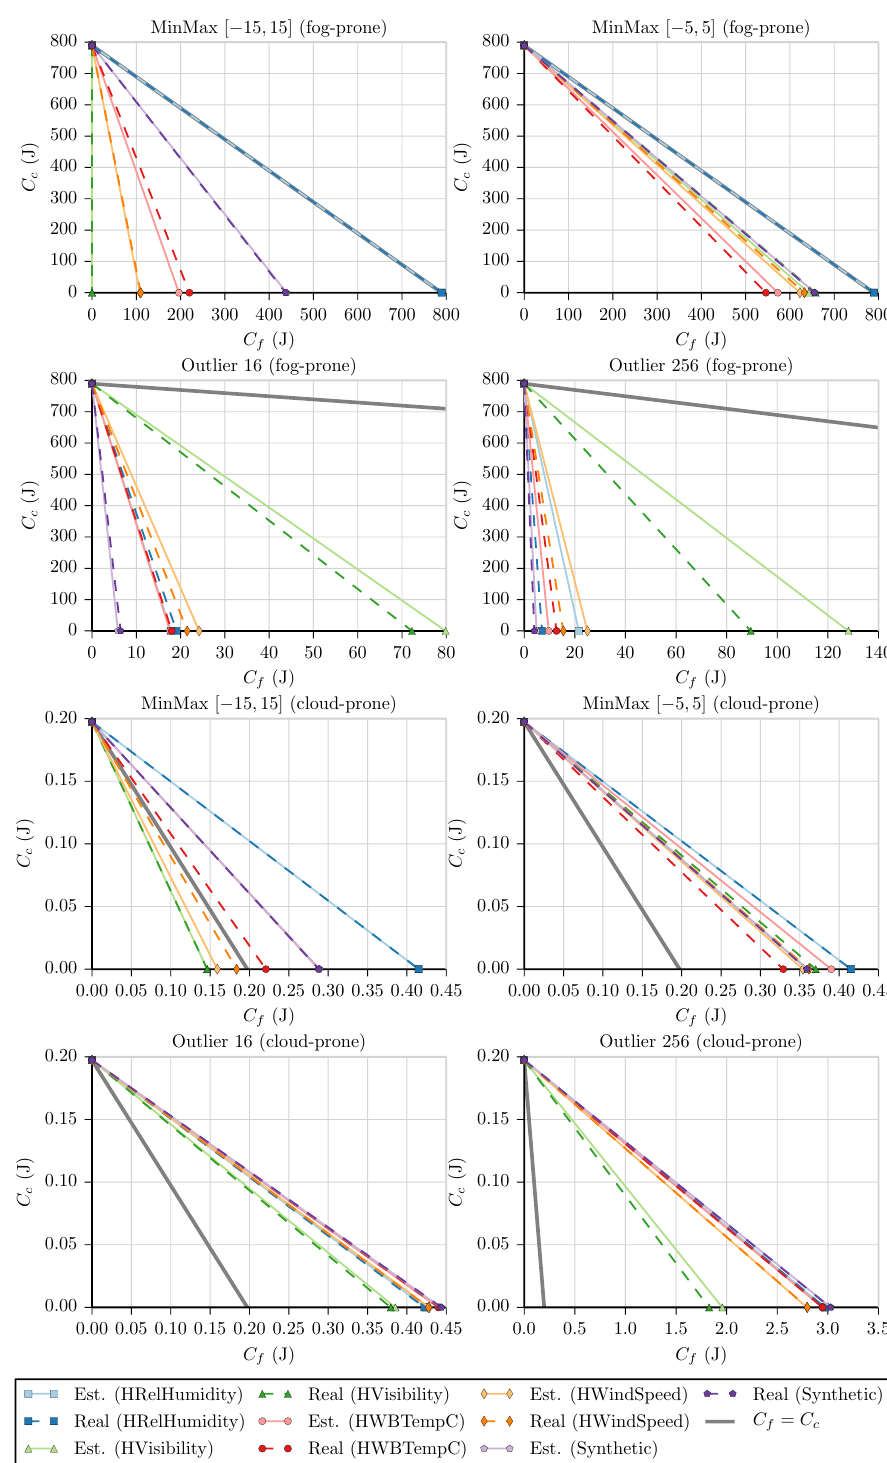
Figure 12. Graphs of the linear equations for each dataset and benchmark using energy consumption as the cost: Raspberry Pi